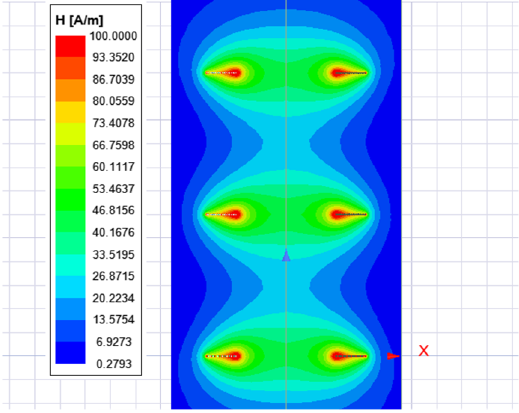
Figure 11. Magnetic field distribution of three coils.